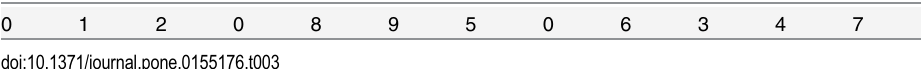
Table 3. Representation scheme 2: Destination-oriented coding.